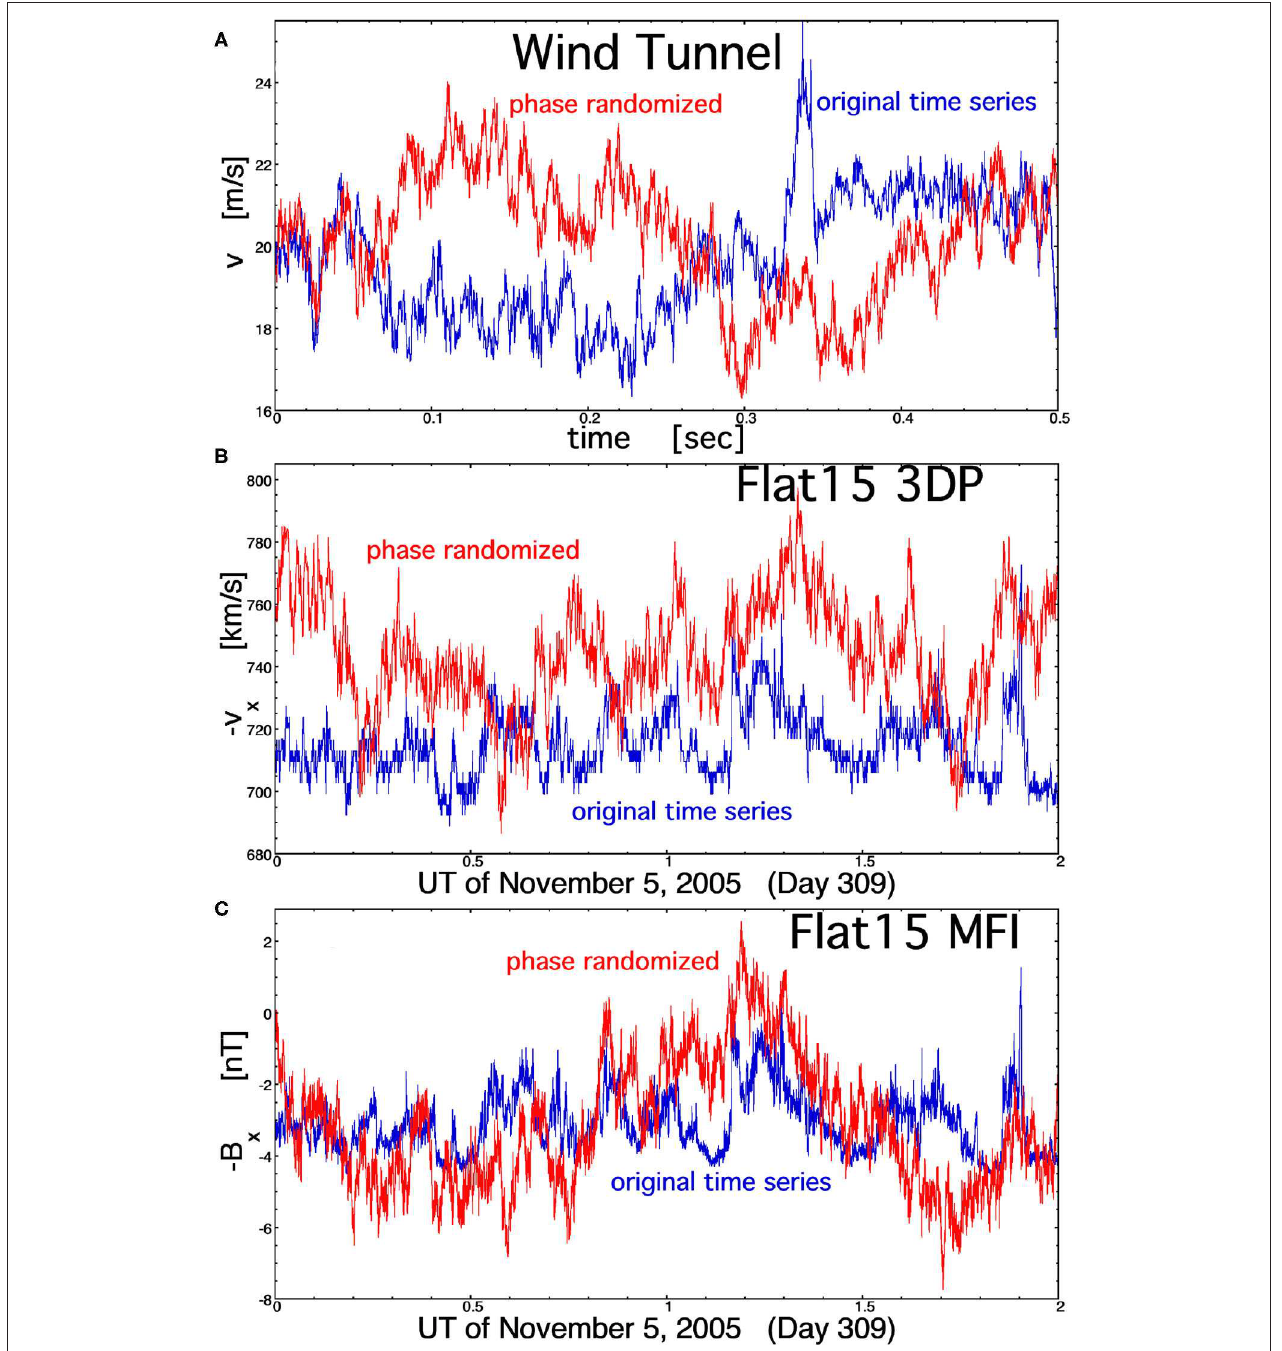
FIGURE 5 | Comparisons of the measurement time series (blue curves) with randomized-phase versions of the time series for (A) the streamwise velocity v in the wind tunnel Navier–Stokes turbulence, (B) the radial (from the Sun) velocity v x for the Alfvénic solar wind fluctuations of Flattop 15, and (C) the radial component of the magnetic field B x for the Alfvénic solar wind fluctuations of Flattop 15. The time duration plotted in each panel is a few correlation times.